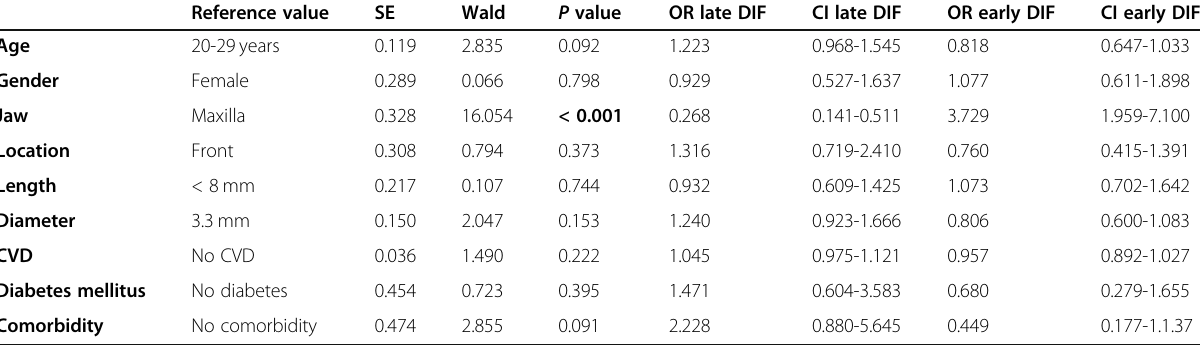
Table 2 Binary logistic regression